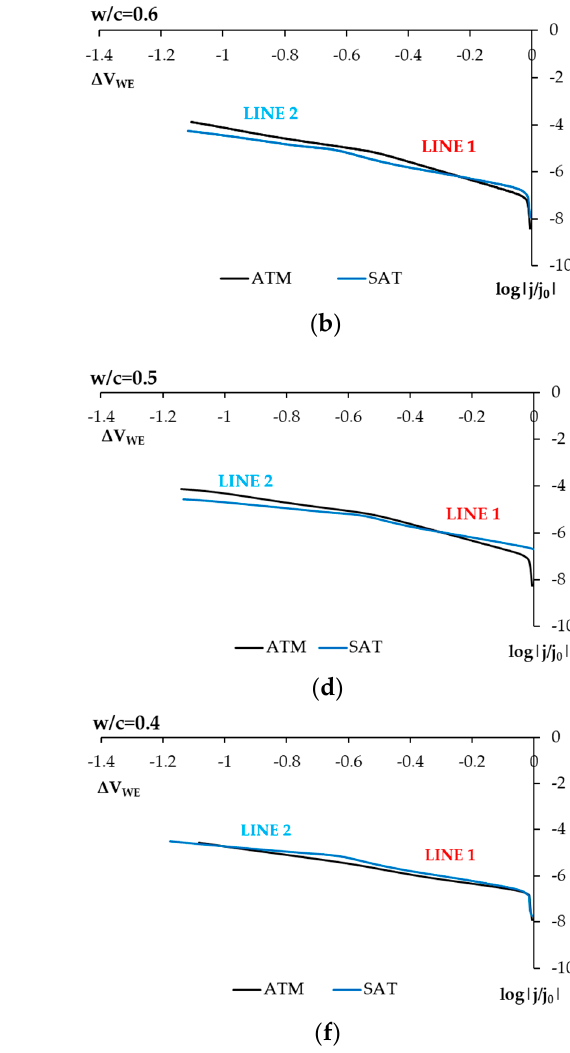
( b ) Figure 9. Results of cyclic voltametry with the SS sensor embedded in a hardened concrete sample of w/c = 0.6 under atmospheric conditions (black solid line, ATM), under partial air pressure condit io n, 500 mbar (green solid line, 500 mbar) and VAC conditions, with practically no O 2 (dashed line, VAC) using the 2-electrode technique. ( a ) Voltagram in which ohm drop is corrected. ( b ) Voltagram of cathodic sweeping represented logarithmically that corresponds to Figure a. Moreover, the logarithmic representation of the voltagrams (Figure 9b) helps to dis- tinguish the two lines observed in solution which, as shown by a former study, have been